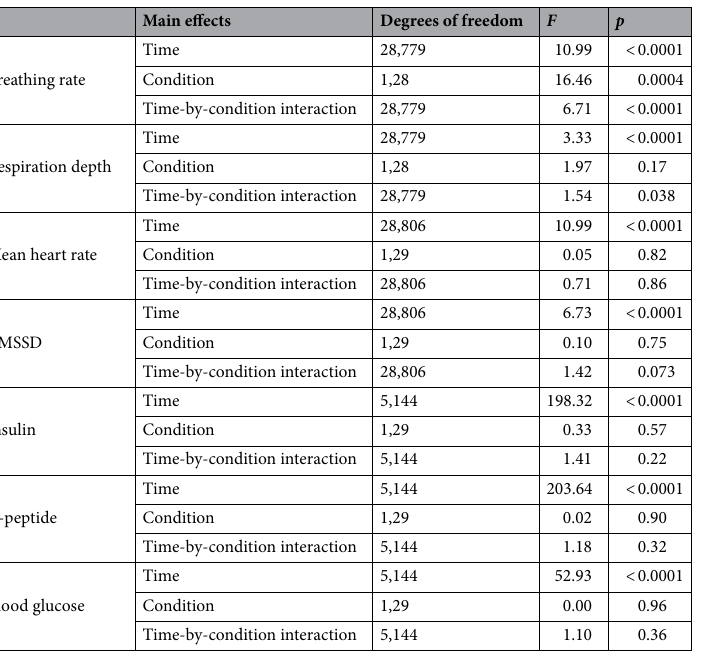
Table 1. Results of mixed model analysis on the effects of slow deep breathing on respiration, heart rate (variability) and